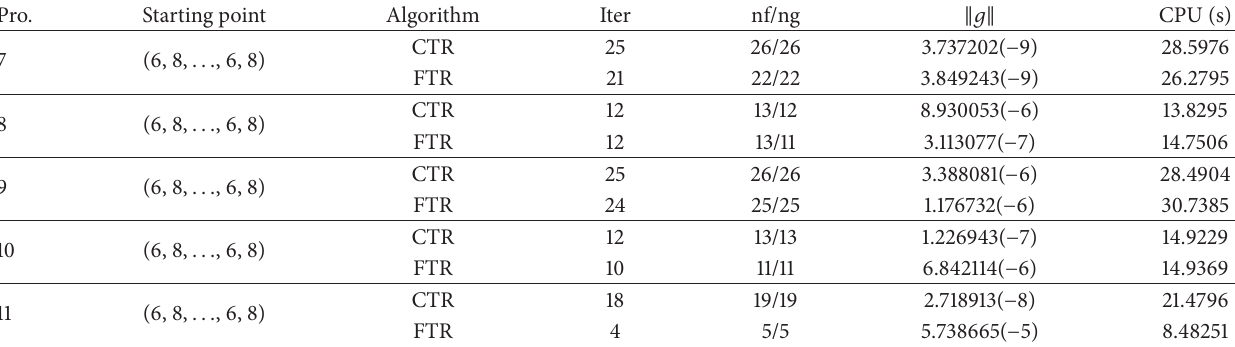
Table 3: The numerical results of Algorithm 7 for some test problems (𝑛 = 3000)